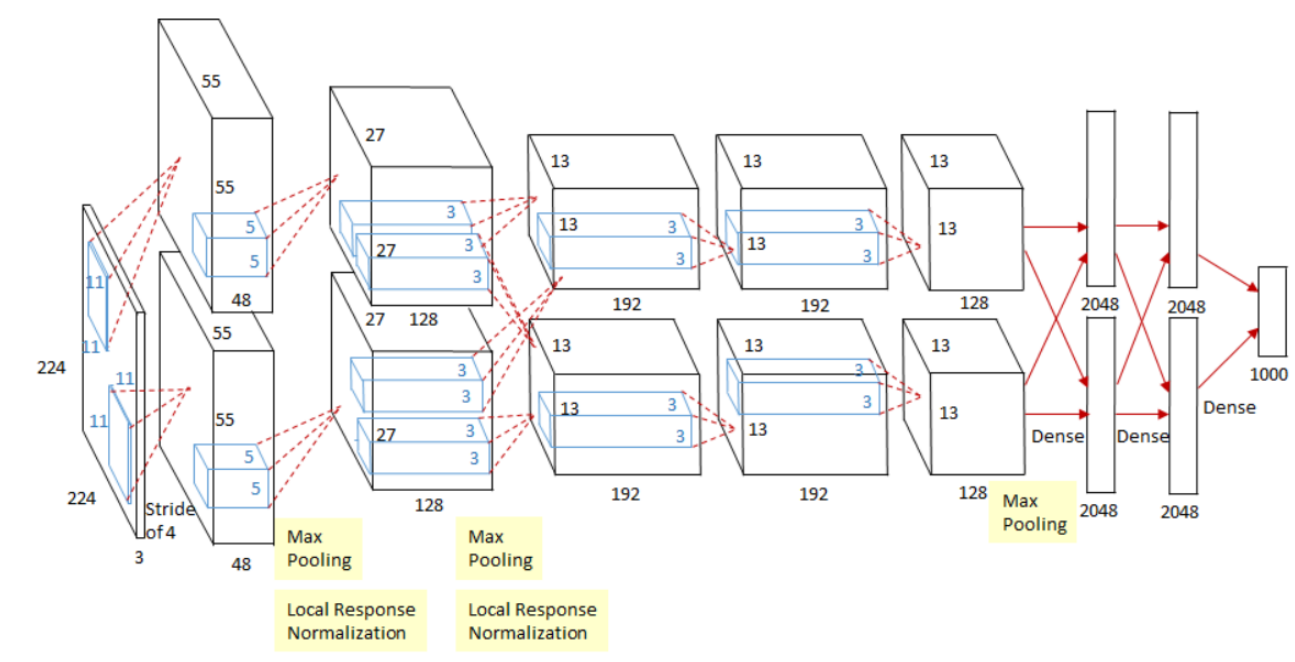
Figure 4. AlextNet have eleven layers: five convolutional layers and three fully connected layers that computes weights; and three max pooling layers